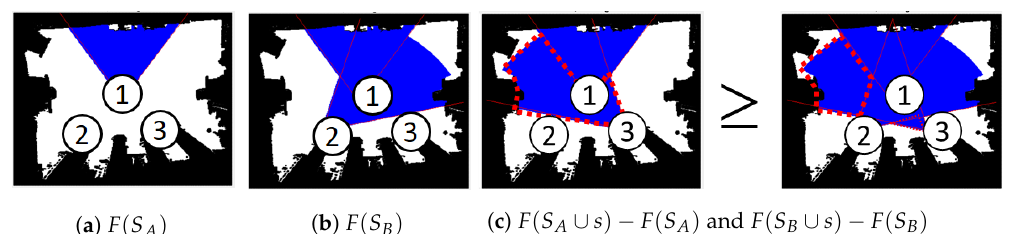
Figure 1. Illustration of submodularity. The decimal number represents the selected sensor. The blue and white colors represent the covered and uncovered areas, respectively. ( a ) F ( S A ) represents the area covered by S A , where S A = { 1 } . ( b ) F ( S B ) represents the area covered by S B , where S B = { 1,2 } . ( c ) The red dash lines represent the submodular gain after adding s , where s = { 3 } . The left figure shows the F ( S A ∪ s ) − F ( S A ) and the right figure shows that F ( S B ∪ s ) − F ( S B )